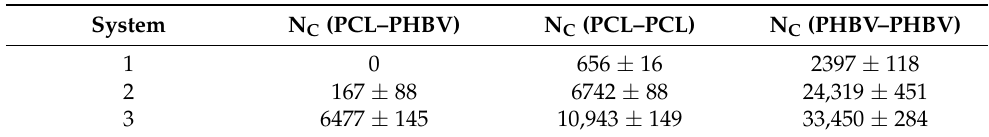
Table 9. The number of close contacts between any pair of the polymer atoms within 0.5 nm averaged over the last 5 ns of the